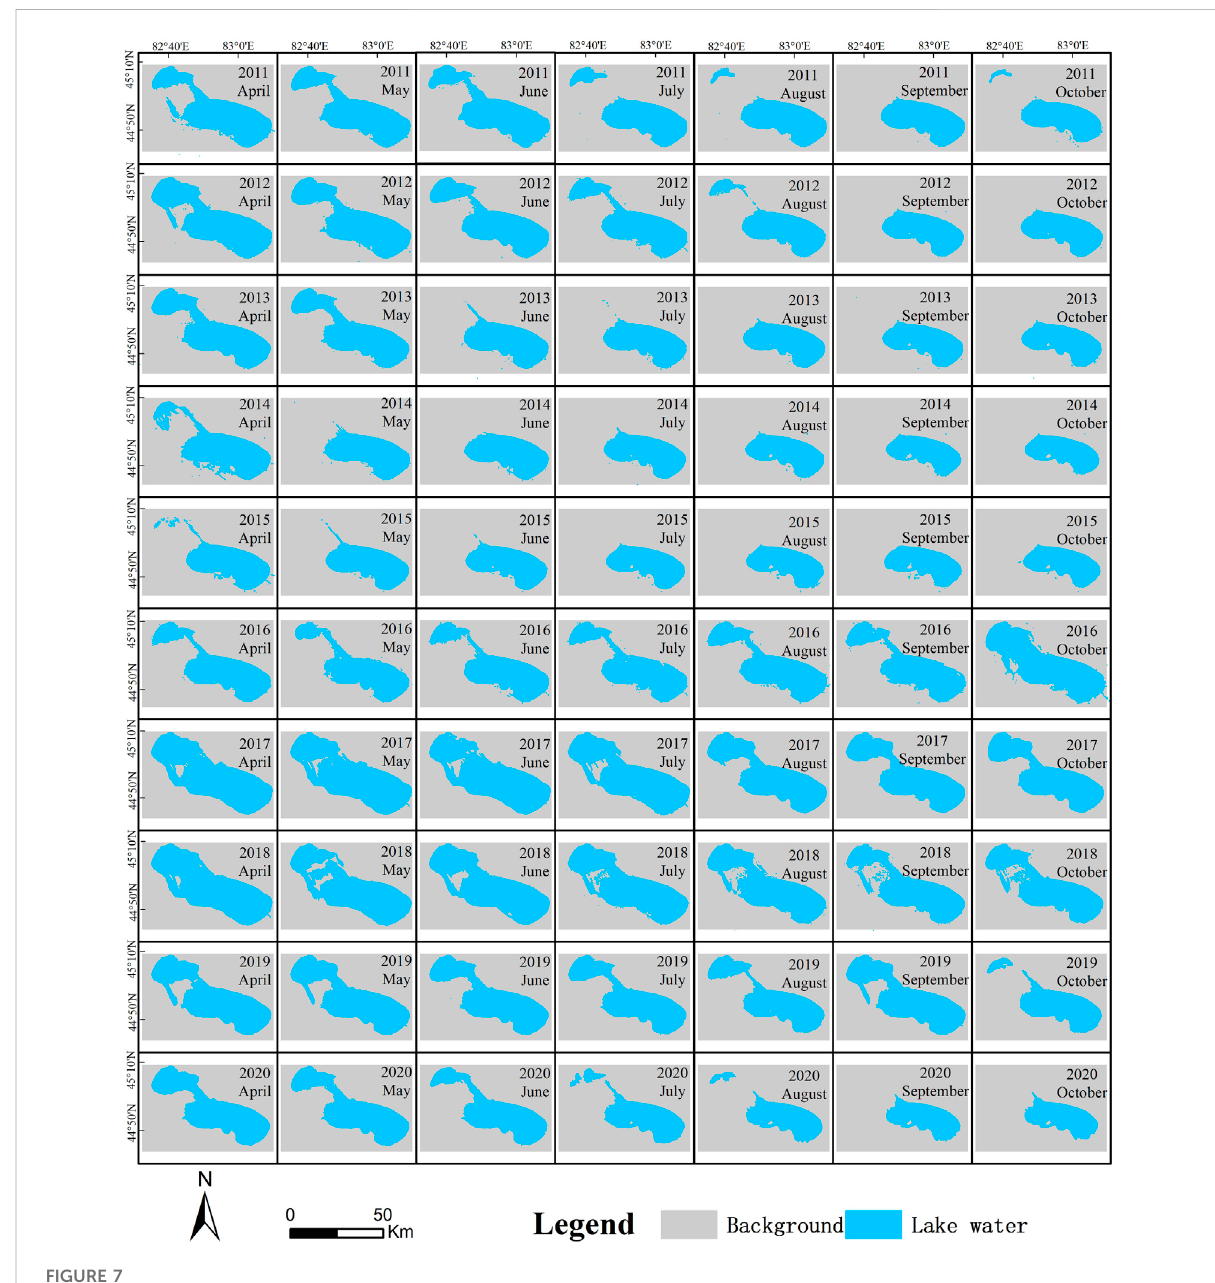
FIGURE 7 Schematic diagram of Ebinur Lake area from April to October 2011 –